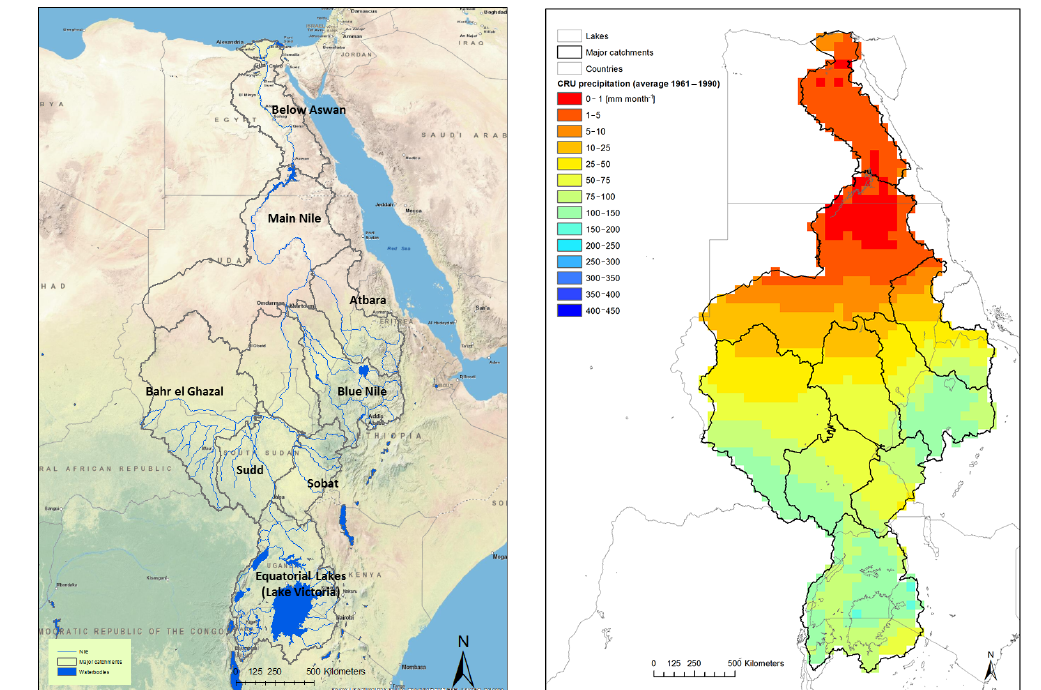
Figure 1. An overview of the Nile Basin (left) and distribution of annual average rainfall in mm/month for the period 1961–1990 (right), from CRU (Harris et al.,